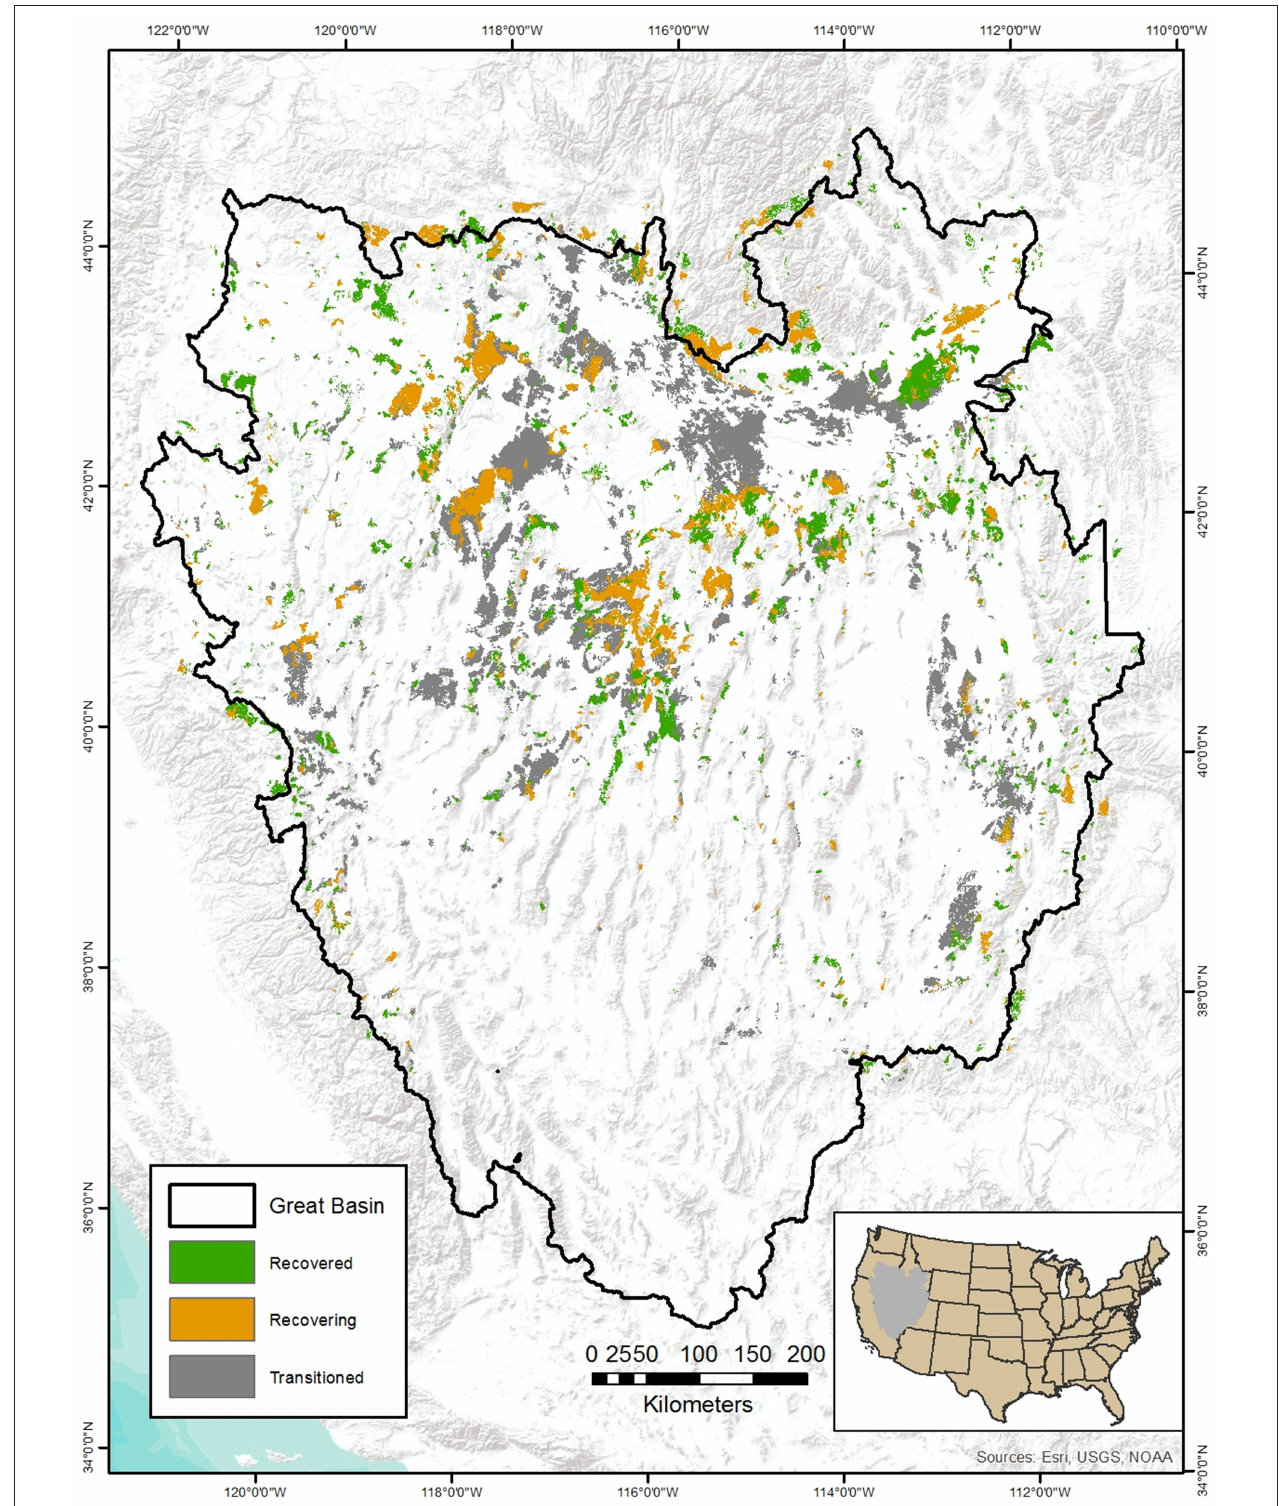
FIGURE 4 | Alternative layer for depicting wildfire impacted areas in Figure 3 derived from geospatial intersections of high and moderate RandR areas with modeled complete or in-progress post-fire recovery, and areas of low RandR with modeled state-transition to annual grass using rules from Coates et al. (2016a).